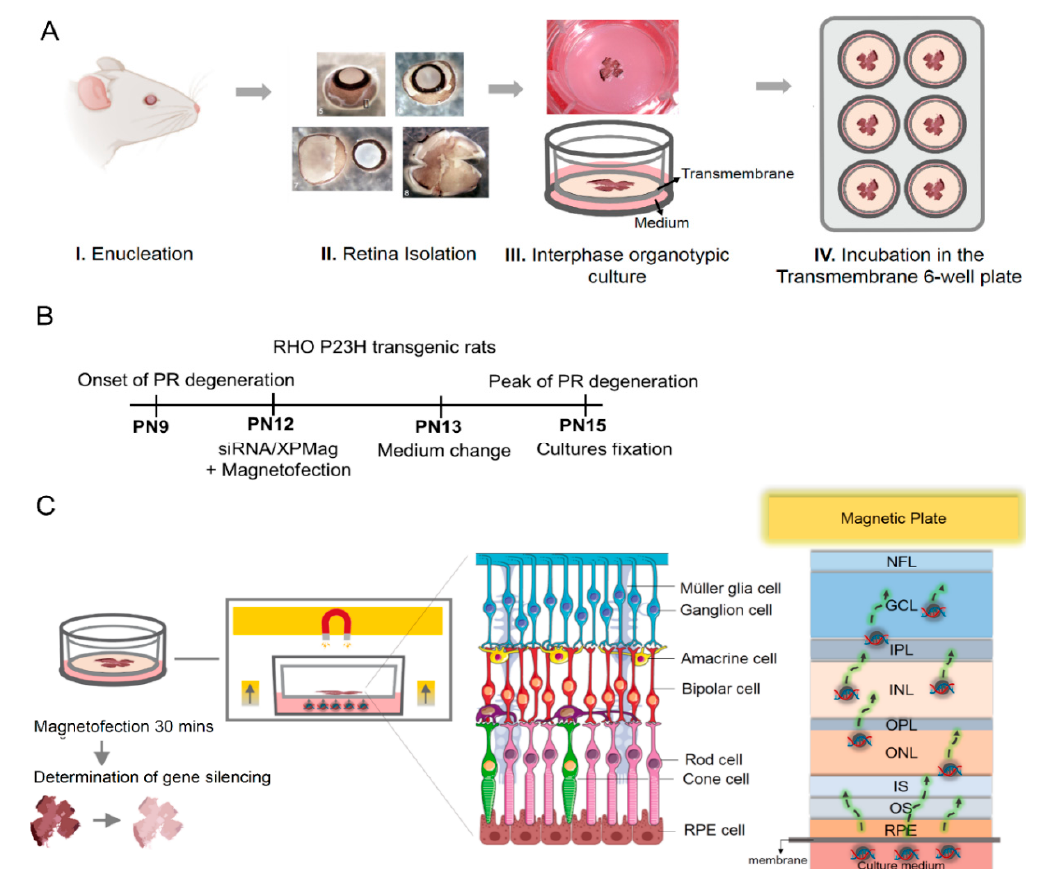
Figure 3. Schematic representation of the preparation of retinal organotypic cultures and Reverse Magnetofection technique used for transfection of siRNA. ( A ) Preparation technique for retina explants. The eyes were enucleated in an aseptic environment (I). Sclera, choroid, and lens were carefully removed, leaving only the neural retina and RPE. Four radial incisions were made to flatten the retina (II). The entire retina with its adherent RPE was mounted flat polycarbonate Transwell ® membranes, with the GCL facing up (III). Inserts carrying the retinae were transferred to 6-well plates and incubated for 3 days (IV). ( B ) Timeline of photoreceptor degeneration in RHO P23H heterozygous transgenic rats and experimental design. Photoreceptor degeneration in RHO P23H rats starts around postnatal (PN) 9 and reaches its peak at PN15. Accordingly, the RHO P23H retinae were isolated from PN12 and silenced for 3 days (72 h) until the peak of degeneration at PN15. ( C ) Illustration of Reverse Magnetofection in retinal organotypic cultures. The Reverse Magnetofection is achieved by adding the siRNA/XPMag MNPs complexes to the culture medium, followed by placing the magnet over the culture plate to attract the complexes to the tissue up to the GCL. The effect of the magnet on the siRNA/MNPs complexes allows siRNA delivery into deeper layers of the explant that are not directly exposed to the